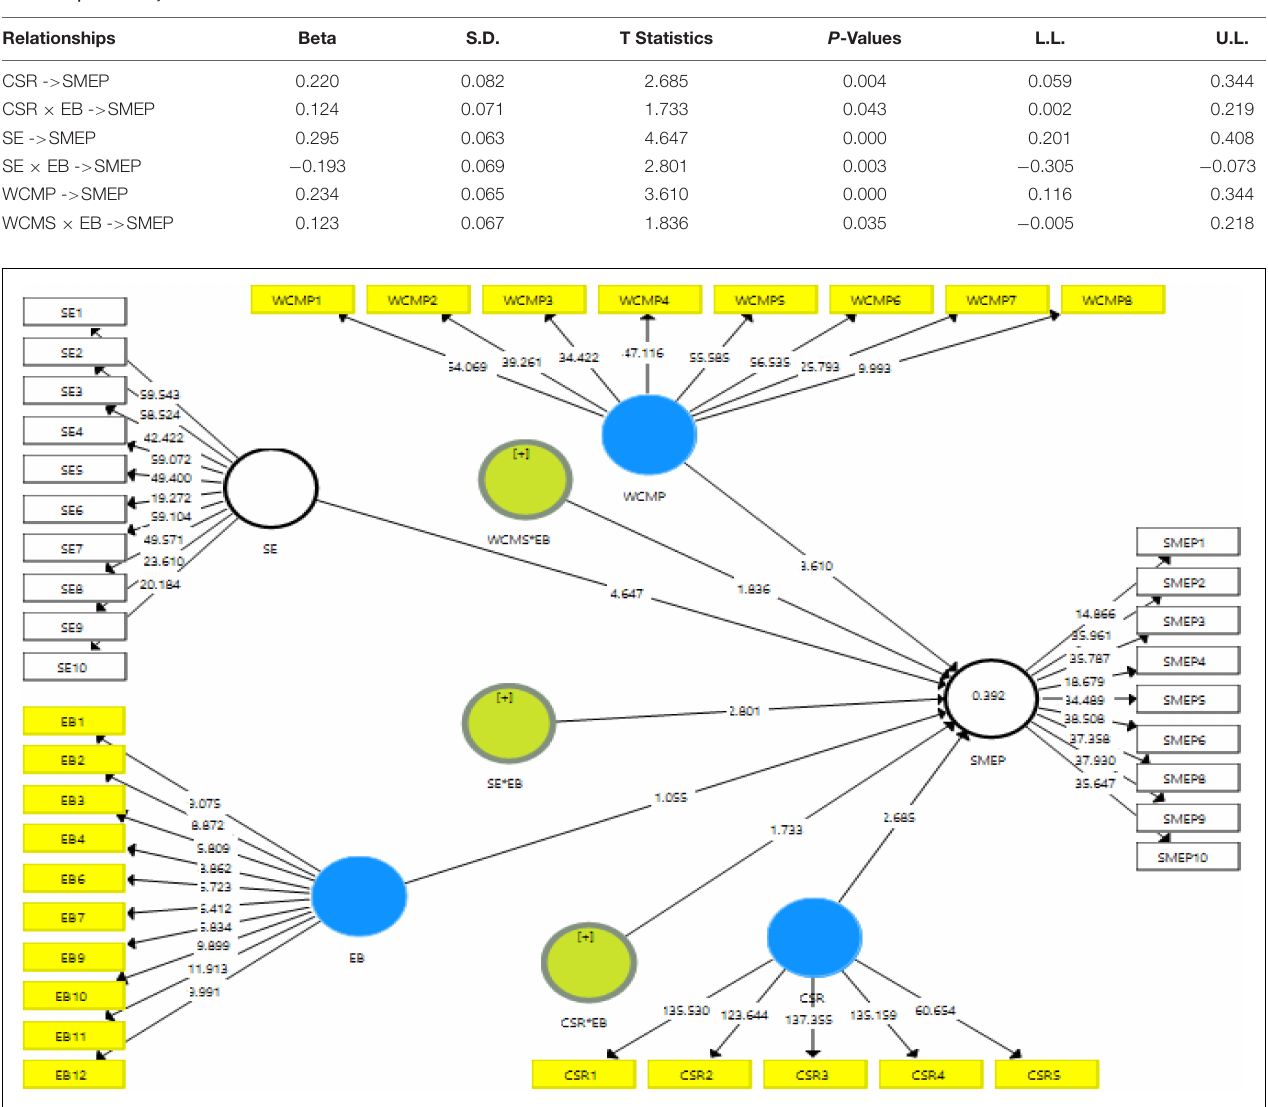
TABLE 6 | Path analysis. Relationships